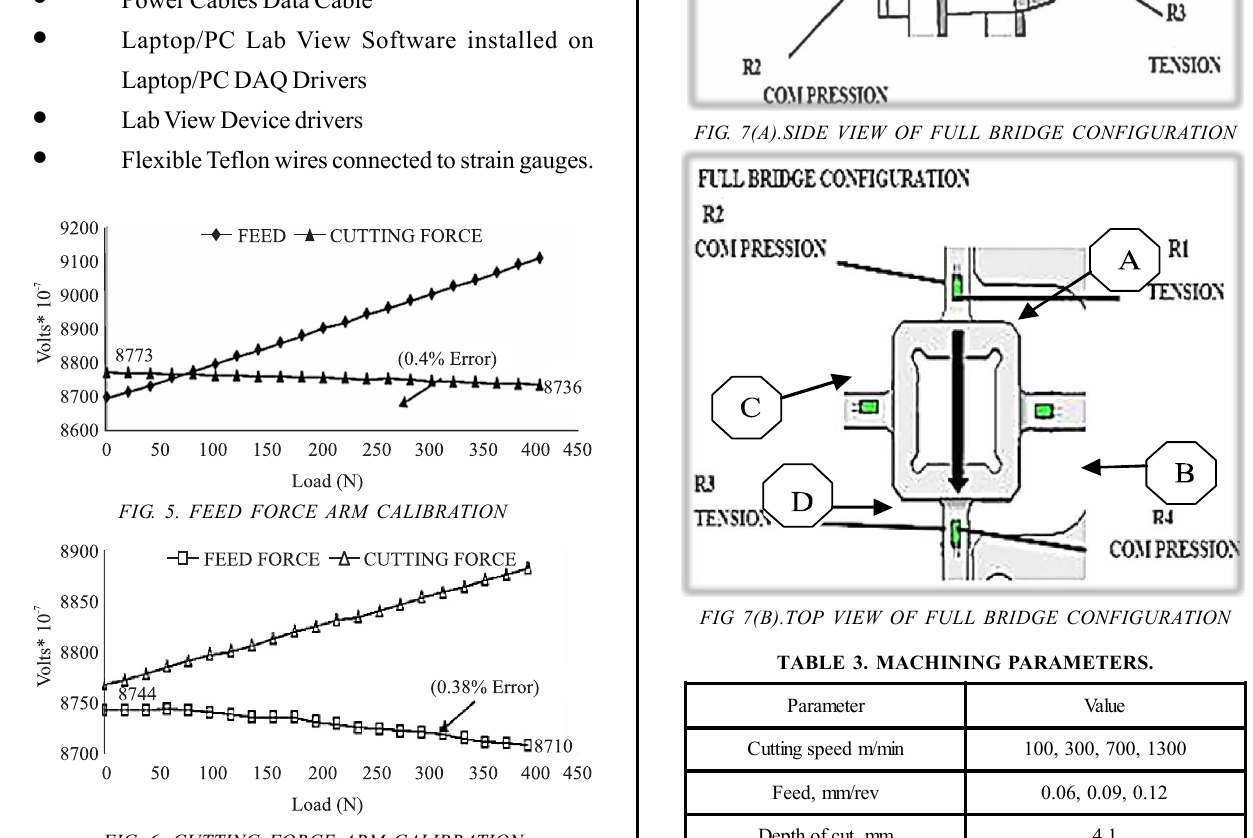
FIG. 6. CUTTING FORCE ARM